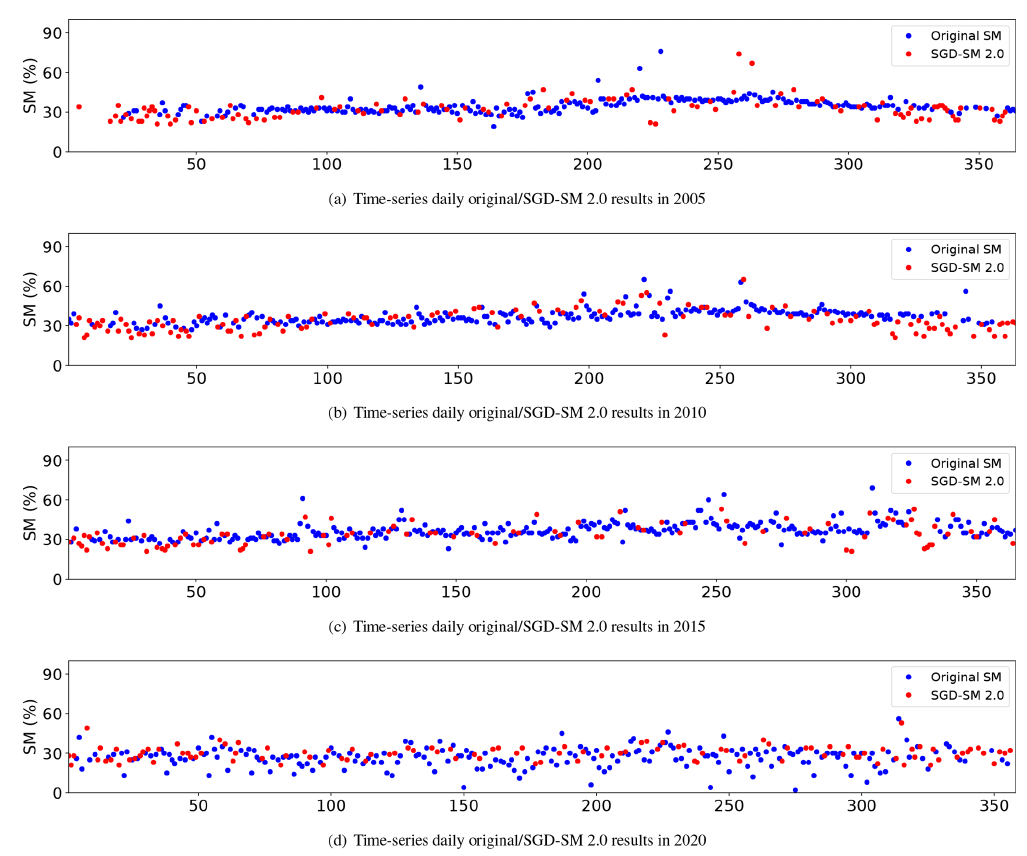
Figure 10. Time-series daily original/SGD-SM 2.0 results of the location (38.375 ◦ N, 117.125 ◦ E) in 2005, 2010, 2015 and 2020.